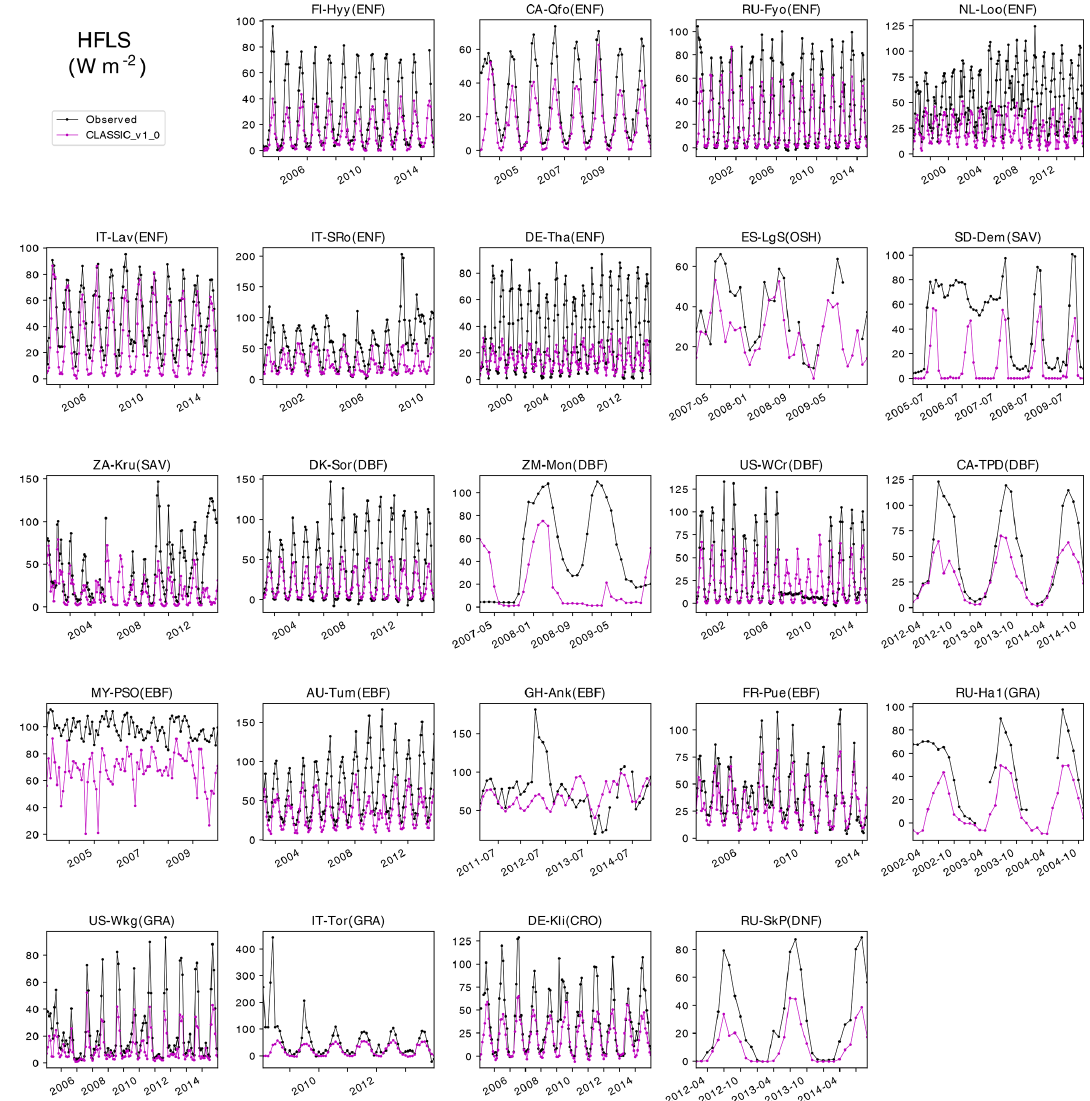
Figure 6. Monthly observed and simulated latent heat fluxes for 23 FLUXNET sites. See caption of Fig. 5 for biome names. Shaded regions indicate the standard deviation across the sample years. Table 1 lists the full site